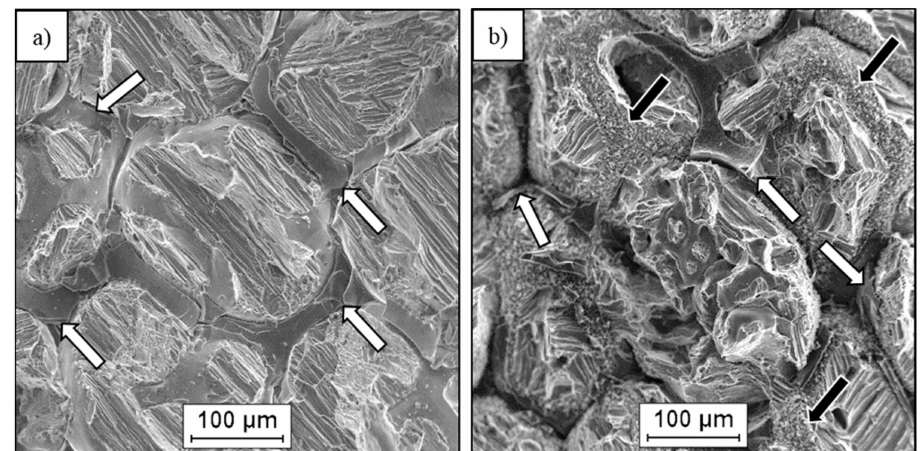
Figure 11. SEM micrographs of fractured surface after flexural tests: ( a ) C of –Mg, ( b ) C of –AZ31, shear bands in magnesium matrix, network of partly destroyed carbon foam (white arrows), agglomerates of fine phases (black